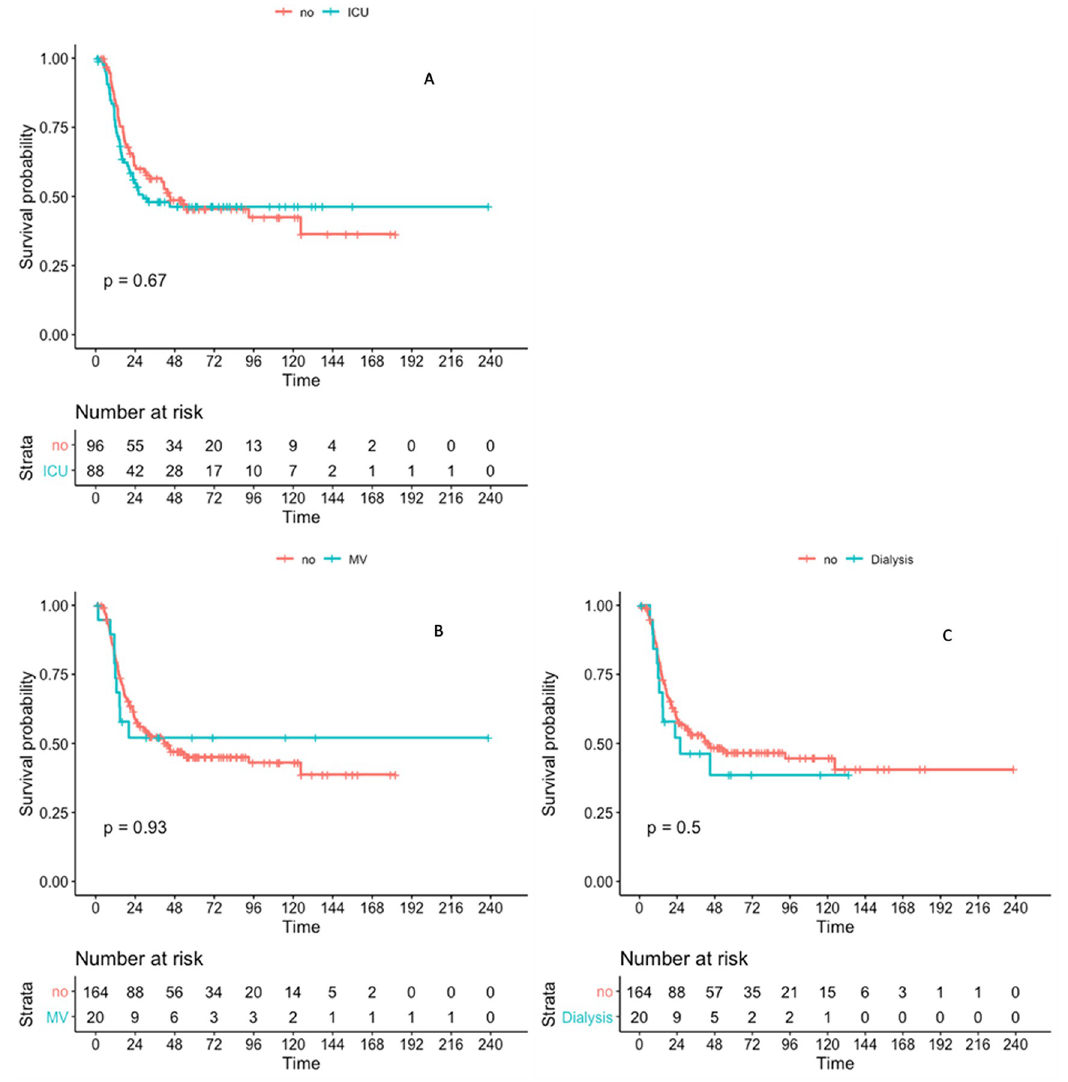
Fig 4. Kaplan-Meyer analysis of overall survival. (A): According to ICU admission status; (B): According to mechanical ventilation status; (C): According to renal replacement therapy status.